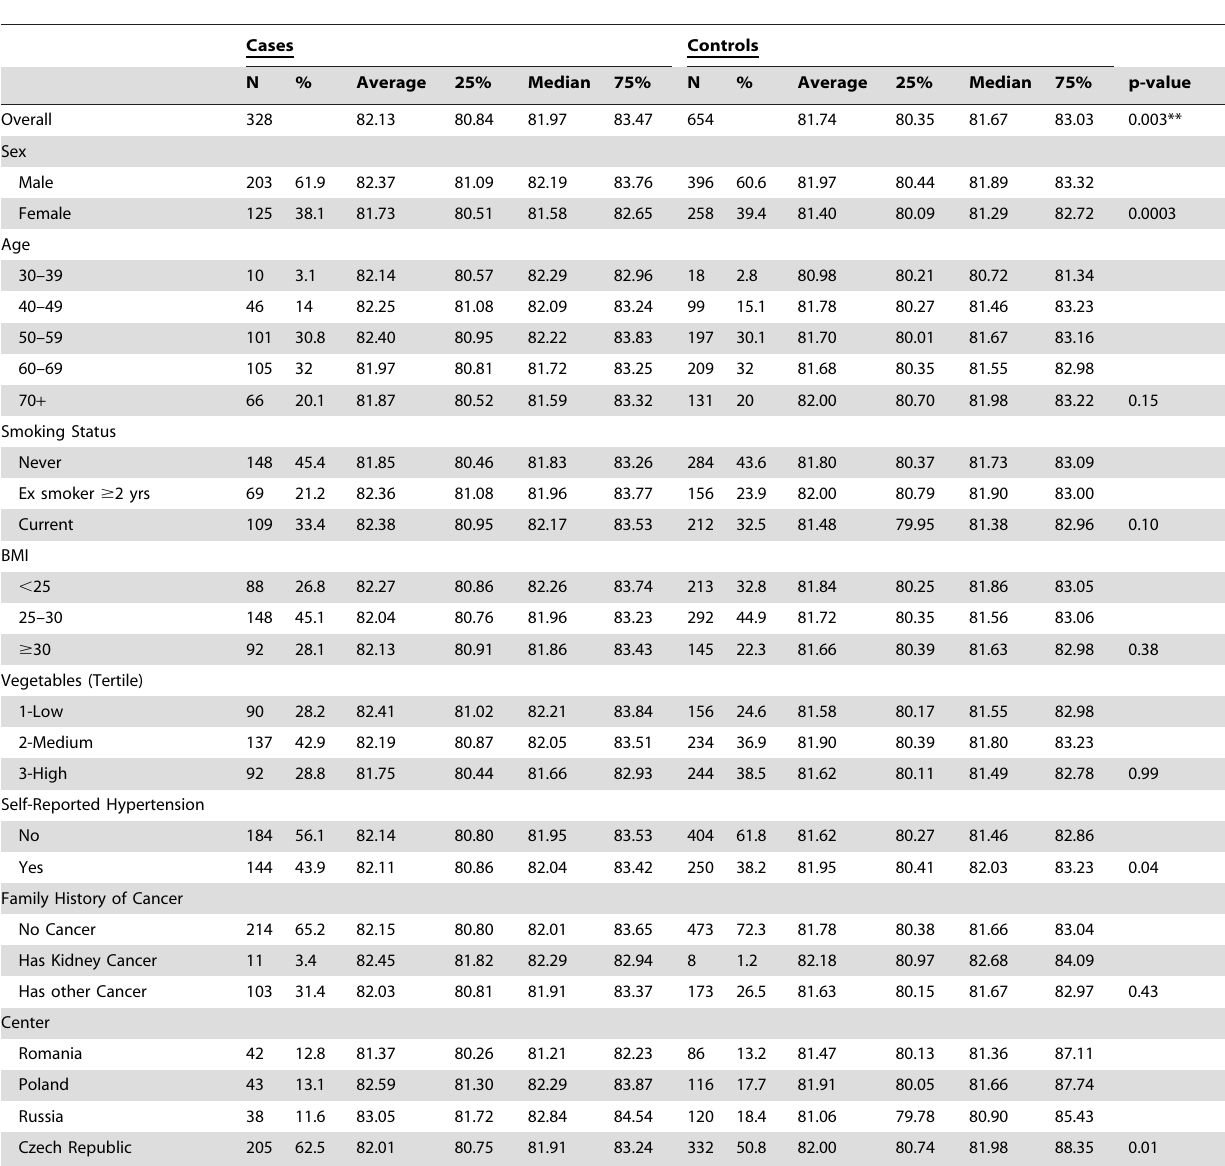
Table 1. LINE-1 Methylation Levels by Characteristics of Study Participants in the Central and Eastern European Renal Cancer